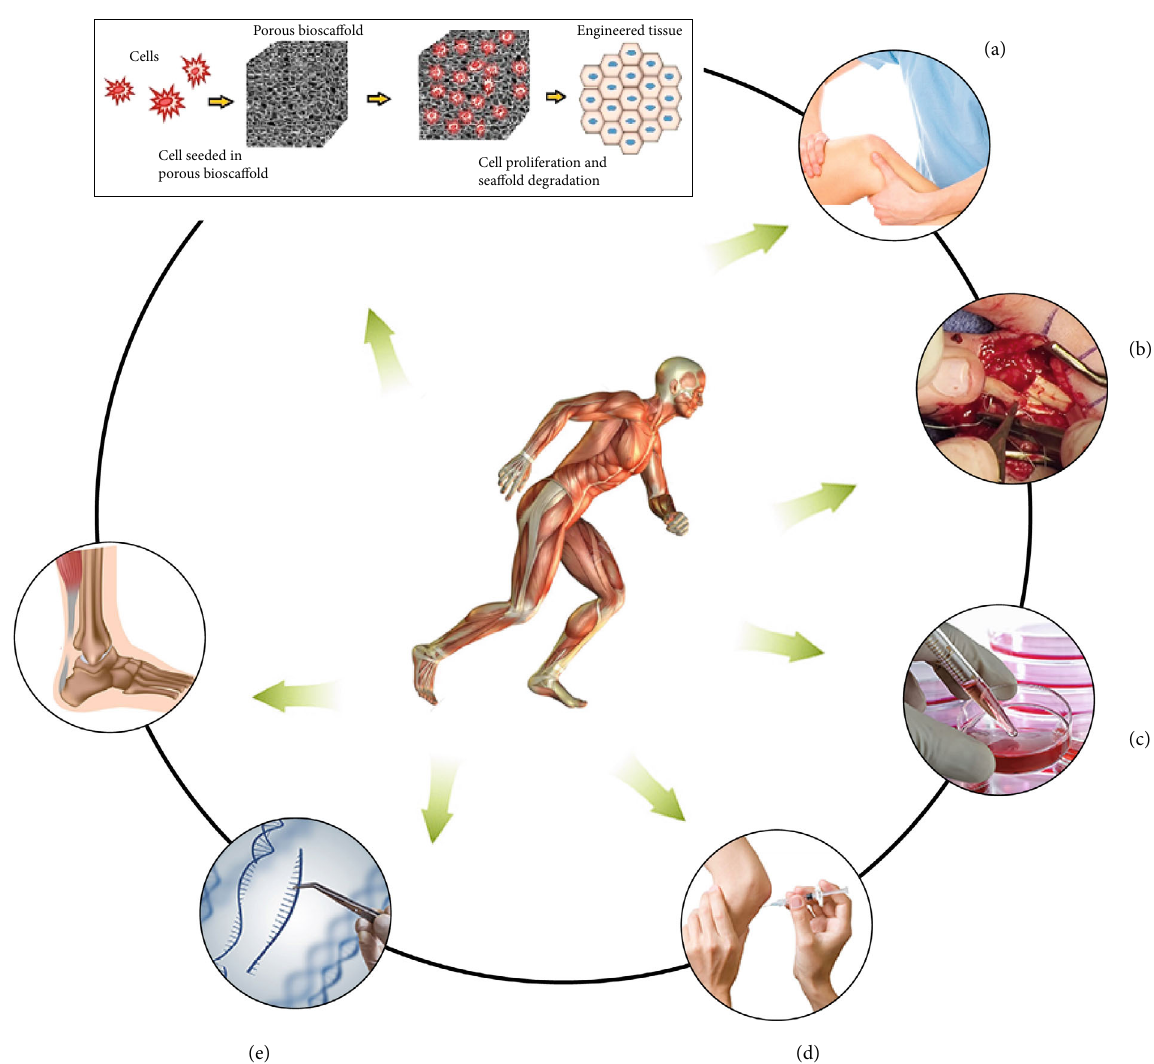
Figure 3: Di ff erent treatment options for tendon repair: (a) physiotherapy facilitates faster healing and collagen realignment, preventing joint sti ff ness, resulting in elevated tensile strength, and better gliding; (b) surgical intervention is usually used and has several disadvantages such as poor integration, mechanical mismatch, necrosis, donor site morbidity tissue rejection, and disease transmission; (c) stem cell therapy facilitates tendon tissue regeneration process; (d) growth factor therapy aims attract stem cells at injury site, support attachment, proliferation, di ff erentiation, and accelerate tendon regeneration; (e) gene therapy aspires to synthesize natural proteins that overcome the problems of externally delivered growth factors; (f) regenerative medicines (tissue engineering) accelerate natural healing process and design biosca ff olds (natural, synthetic, and composite) for the rehabilitation of tendon tissue, to deliver growth factors, to stimulate cell proliferation and di ff erentiation. Reproduced with permission from references [53 –